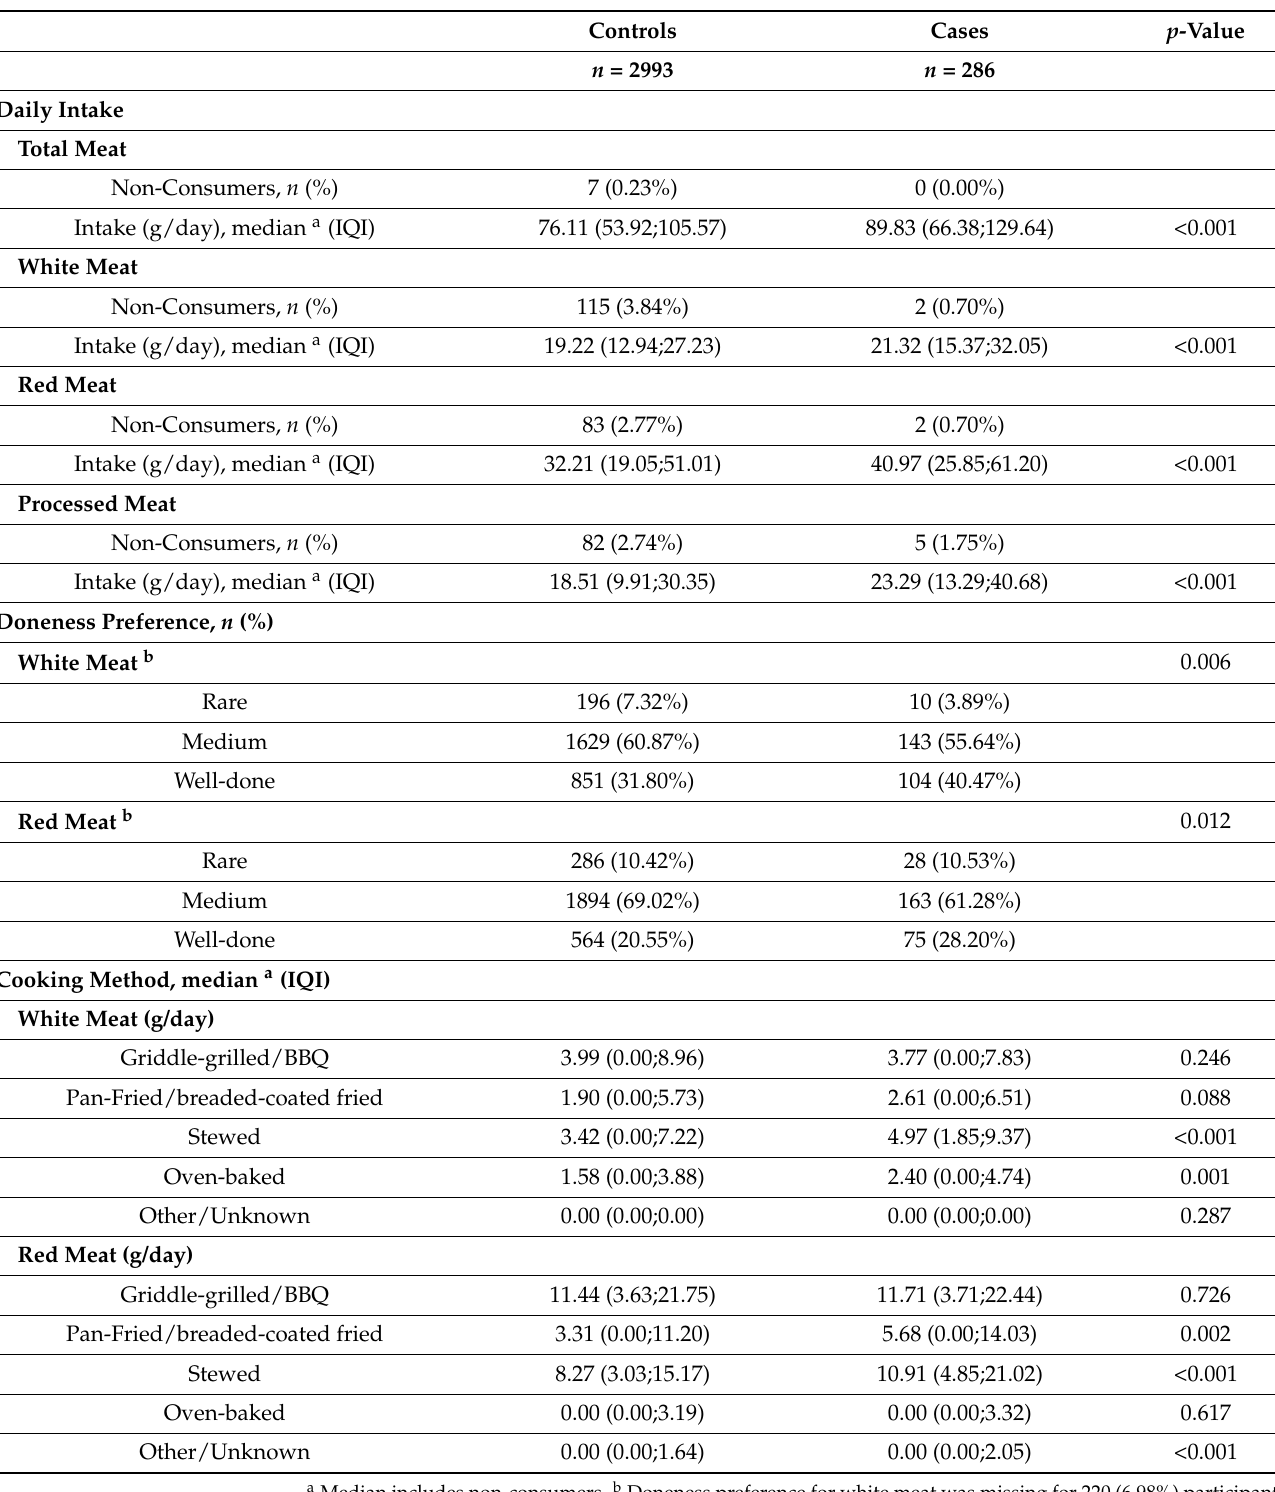
Table 2. Description of meat intake, doneness preference and cooking methods for controls and gastric adenocarcinoma cases in the MCC-Spain